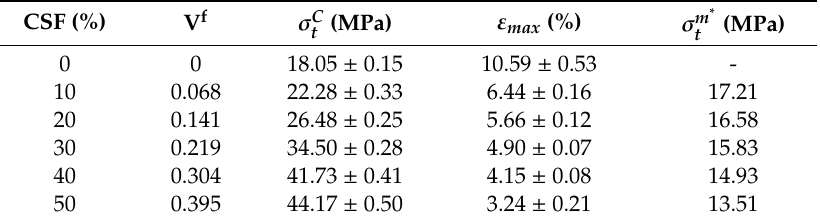
Table 5. Tensile strength and strain at break and contribution of the matrix of the 0 to 50 wt.% CSF reinforced BioPE composites coupled with 6 wt.% of MAPE.